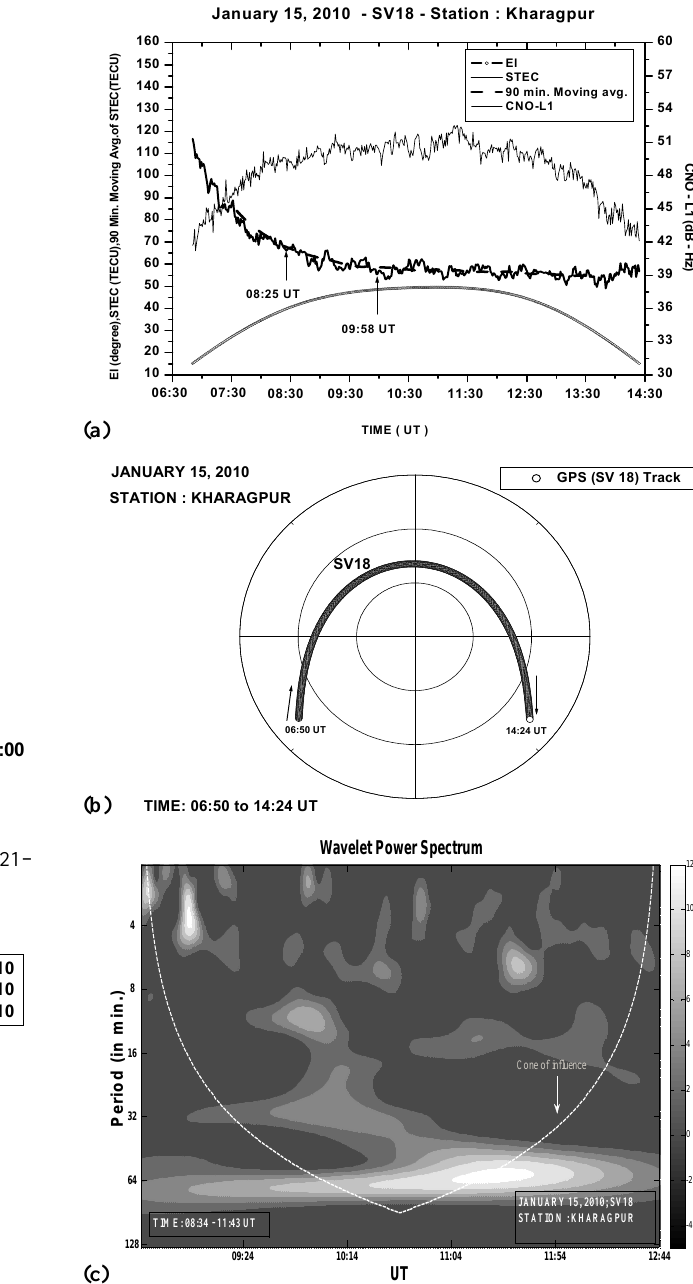
Fig. 12. Variation of slant TEC (STEC), elevation angle, 90-min moving average and carrier-to-noise ratio at GPS L1 frequency (CNO-L1) along the track of SV18 during 06:50–14:24UT of 15 January 2010 is shown in (a) and the corresponding polar plot from Kharagpur is shown in (b) . Waves with periodicities of 8min were detected in the wavelet spectrum of deviations in TEC from the 90-min moving average recorded on the SV18 link around 10:35UT as depicted in (c) . At that time, the satellite was located almost due north of the station as shown in (b) . The white ellipse indicates the cone of influence within which results are